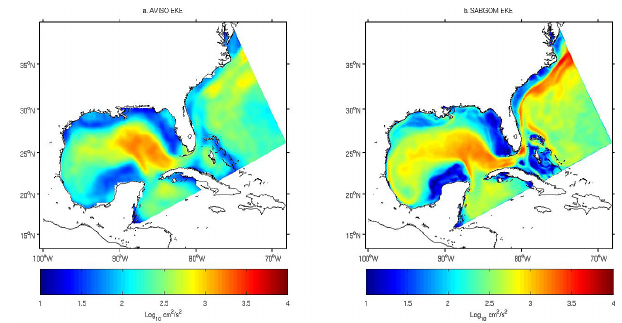
Fig. 5. Comparison of 7yr (2004–2010) mean eddy kinetic energy calculated based on (a) AVISO SSH observation and (b) SABGOM model simulated